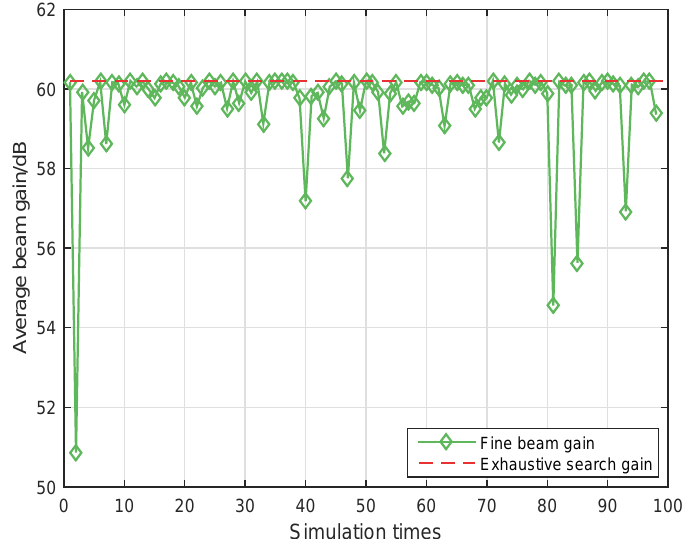
Figure 8. Cumulative gain obtained by the 3D BSL-VT algorithm, N = M = 32, α =